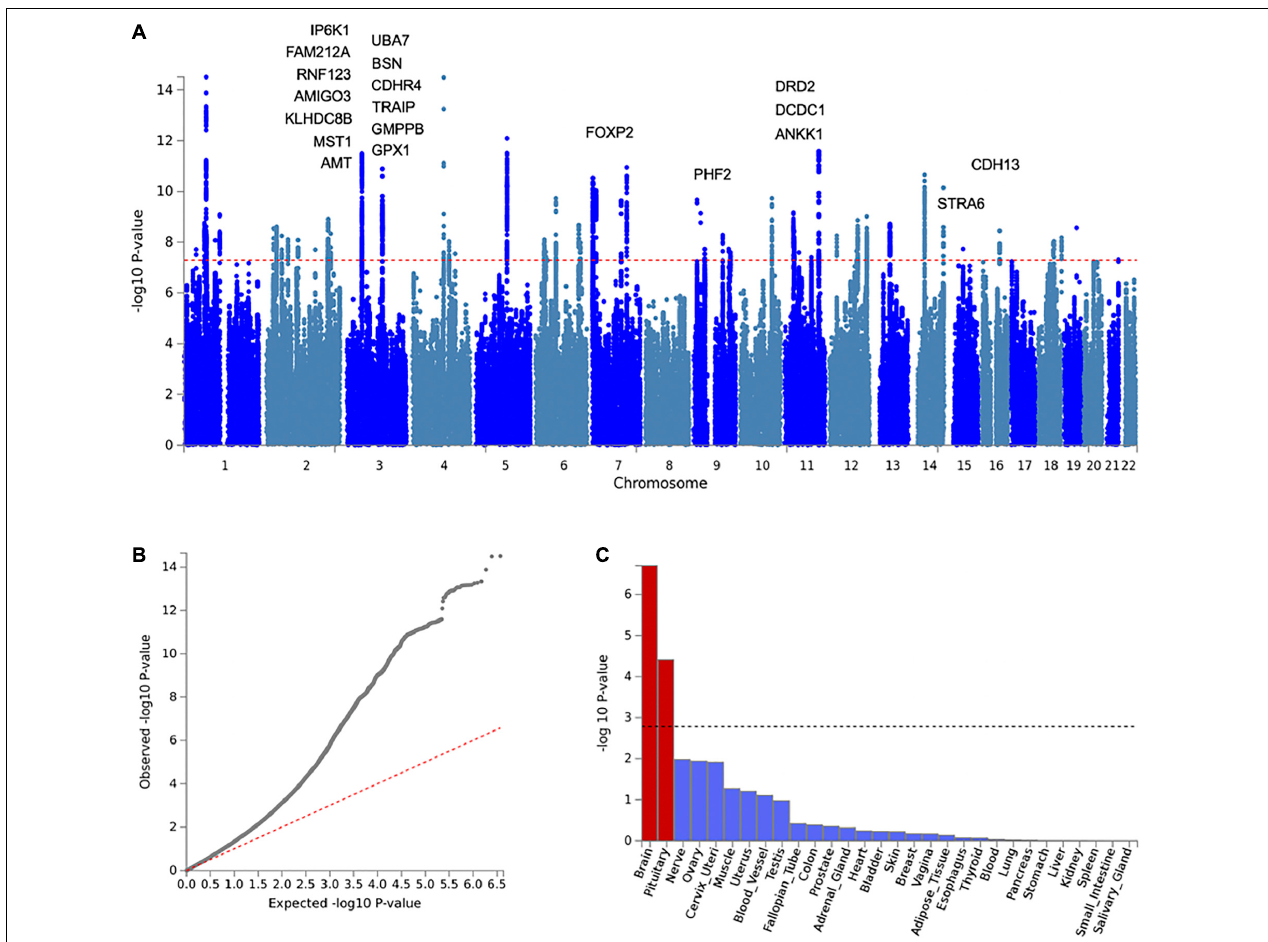
FIGURE 3 | Cross-disorder meta-analysis results of OA and MD. (A) Manhattan plot with labels for the top 20 of 42 genes significantly associated with both OA and MD (gene-based P meta ≤ 2.64 × 10 − 6 , P OA ≤ 1 × 10 − 4 , P MD ≤ 1 × 10 − 4 ). (B) Q-Q plot of the meta-analysis results showing expected vs. observed –log( P ) for examined SNPs. The red dotted line indicates a situation when observed p -values exactly match what would be expected by random chance. (C) Graphic showing results of tissue-specific enrichment analysis for 30 general tissue types. The X-axis represents the examined tissues, while the Y-axis represents the enrichment p -values at the minus log scale. The black dotted line indicates a statistical significance level after multiple testing